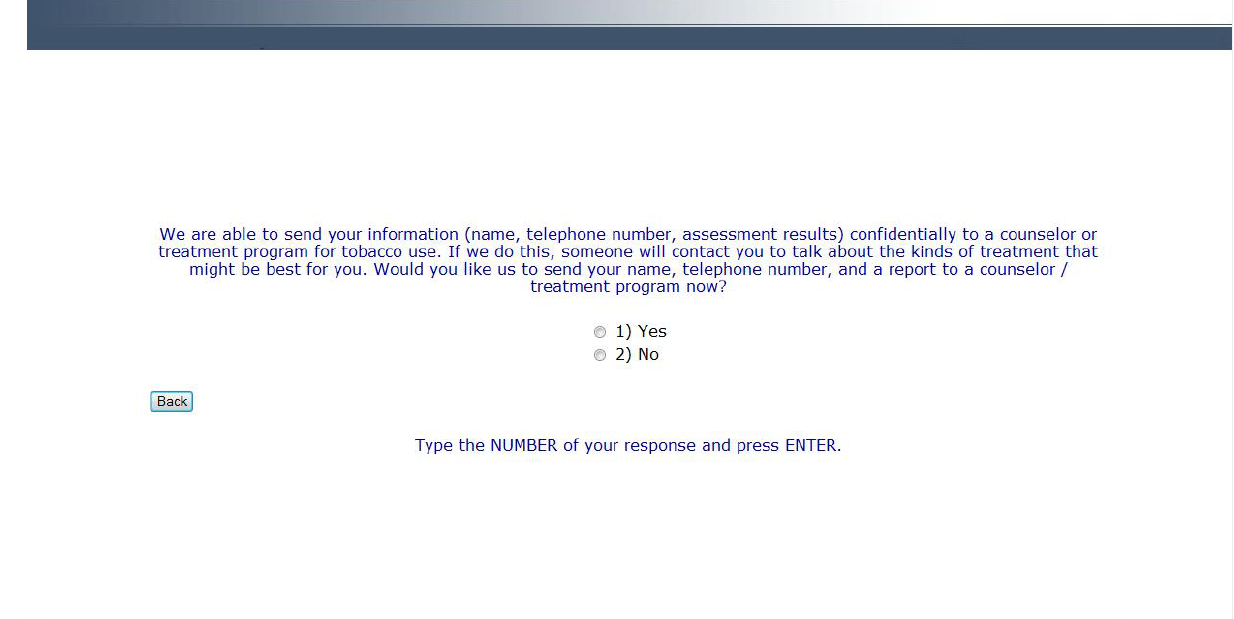
Figure 4. Screenshot from the CABIT program showing how patients are asked if they would like a referral to a treatment